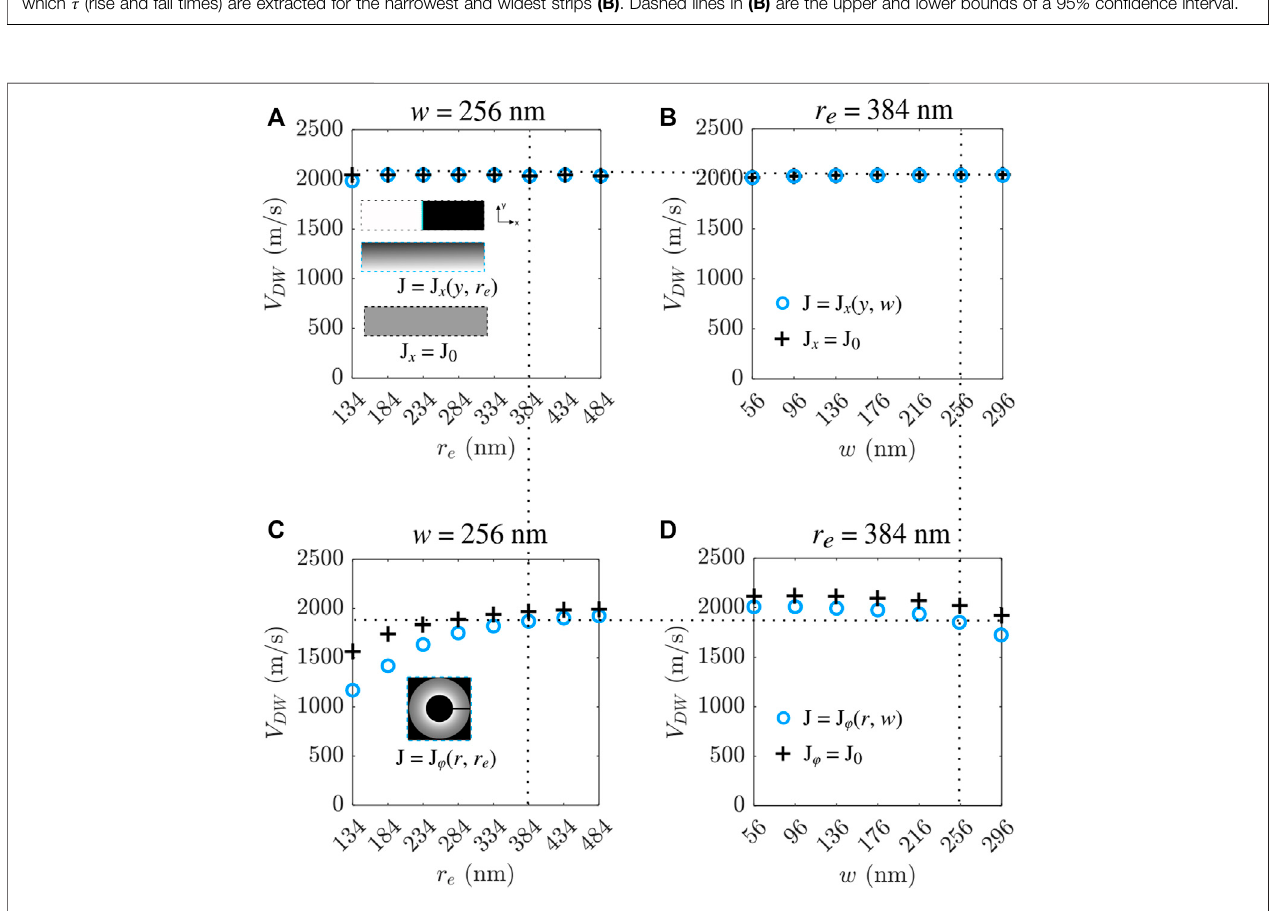
FIGURE 7 | DW terminal velocities in a straight strip for an inhomogeneous J ( y , w , r e ) (blue circles) and for a uniform J 0 (black crosses) as a function of radius r e (A) andwidth w (B) atsametemperature( T (cid:2) 260 K).Insetsin (A) showthemagneticcon fi gurationofsublattice i (cid:2) 1at t (cid:2) 0andschematicsofthecurrentspatialdistribution inthestripsasexamples. (B) DWterminalvelocitiesinacurvedstripswiththesameparameters asafunctionofradius r e (C) andwidth w (D) .Asanexample,insetin (C) showstheradialdependenceofaninhomogenouscurrentdistributioninsuchastrip.Dottedlineshighlightthecaseswherethetwogeometricalparameters( w and r e ) are coincident among all the